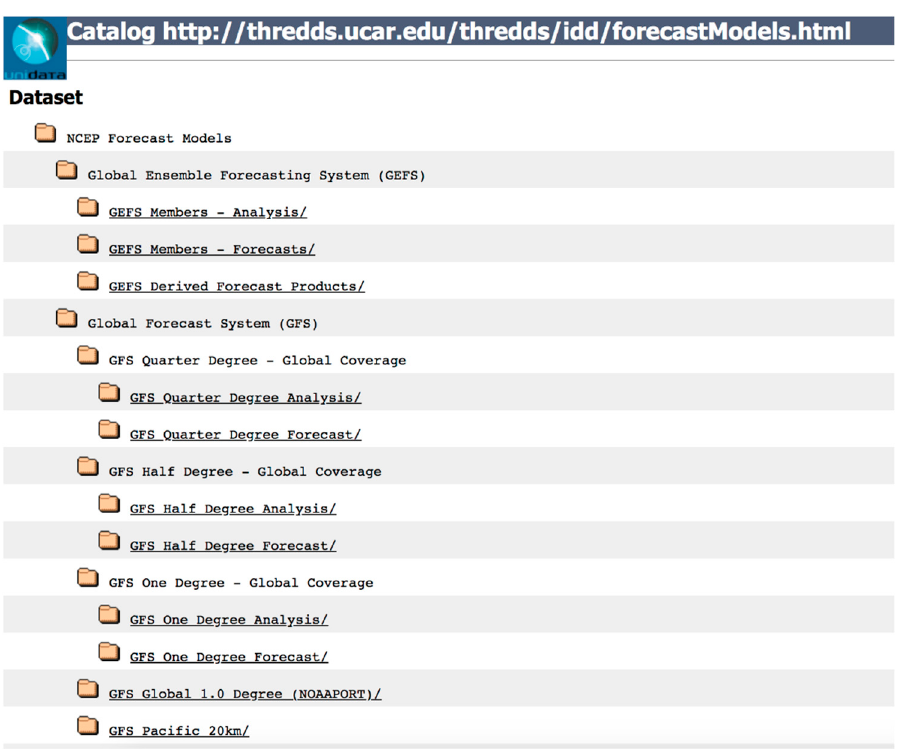
Figure 2. Top level Unidata THREDDS Data Server (TDS) catalog listing.